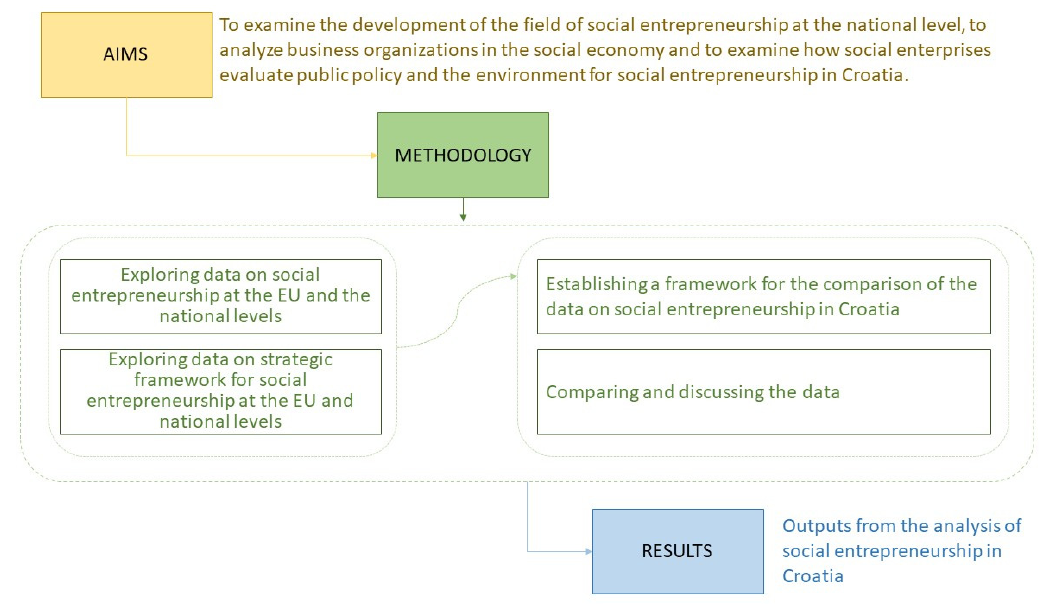
Figure 3. A flow chart summarizing the aims–methodology–results path. Source: Authors.